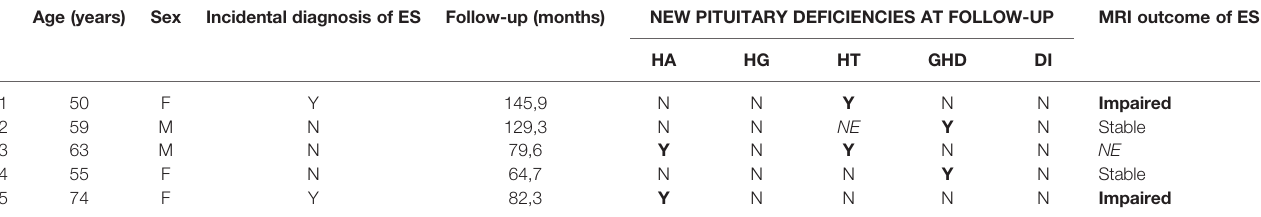
TABLE 4 | Individual data of patients with empty sella who developed pituitary de fi ciency during the follow-up. Age (years) Sex Incidental diagnosis of ES Follow-up (months) NEW PITUITARY DEFICIENCIES AT FOLLOW-UP MRI outcome of ES